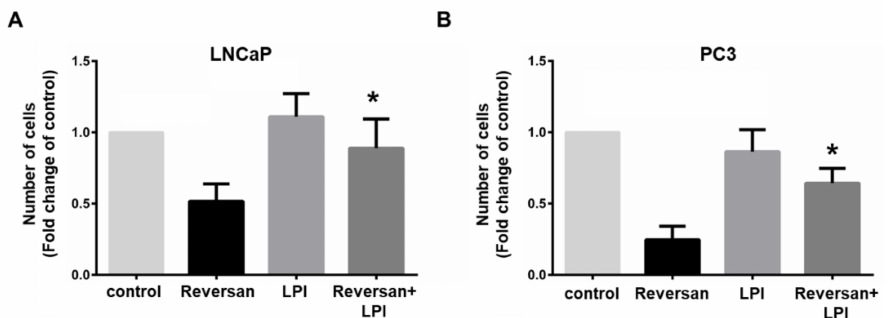
Figure 4. Exogenous LPI reverses the e ff ect of Reversan on prostate cancer cells. Prostate cancer cell lines LNCaP ( A ) and PC3 ( B ) were treated with 10 µ M Reversan, 10 µ M LPI or a combination of the two. Control cells were treated with respective vehicles, as specified in the Materials and Methods section. Number of cells was assessed after 72 h by cell counting. Data are expressed as fold change of cells treated with each corresponding vehicle and are means + SEM of n = 3 independent experiments performed in duplicate. * p < 0.05 vs.